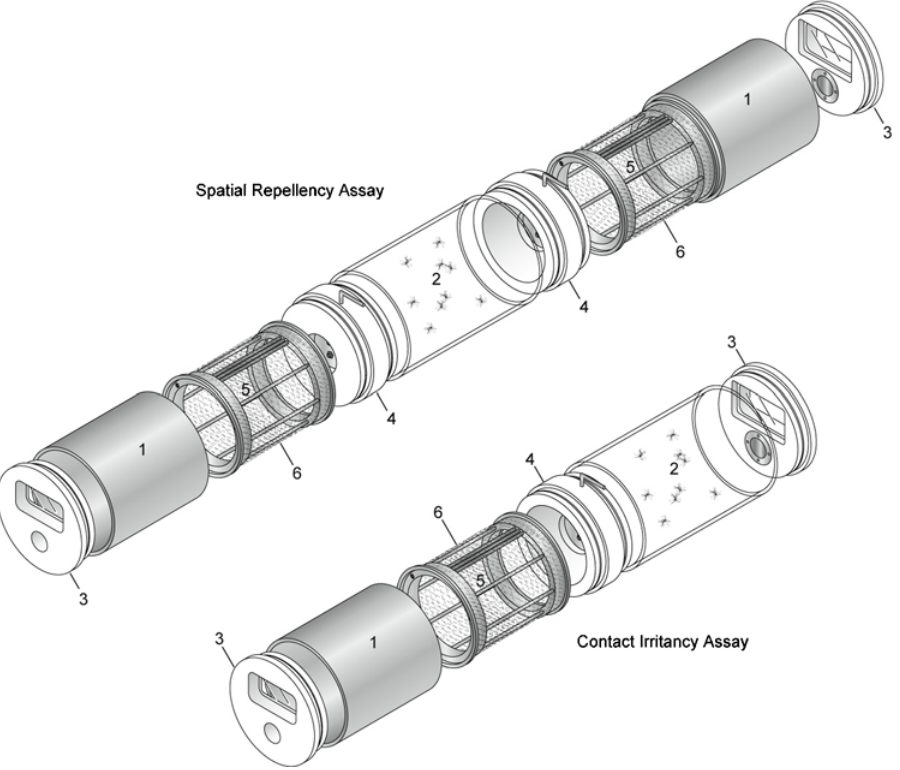
Figure 1. Schematic drawing of the high-throughput screening system showing the spatial repellency assay (top) and contact irritancy assay (bottom) assemblies. Major components include: 1, treatment (metal) cylinder; 2, clear (Plexiglas) cylinder; 3, end cap; 4, linking section; 5, treatment drum; and 6, treatment net.